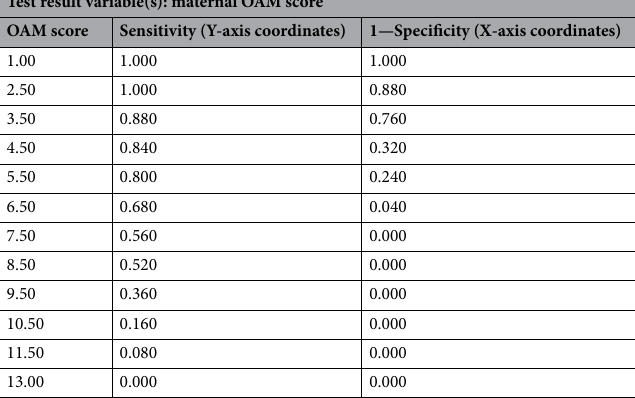
Table 3. Sensitivity and 1-specificity values at different AMS, calculated based on the ROC curve (Coordinates of the curve) in B-S kinship analysis by X-STR. The smallest OAM cutoff value is the minimum observed test value minus 1, and the largest cutoff value is the maximum observed test value plus 1. All the other cutoff values are the averages of two consecutive ordered observed test